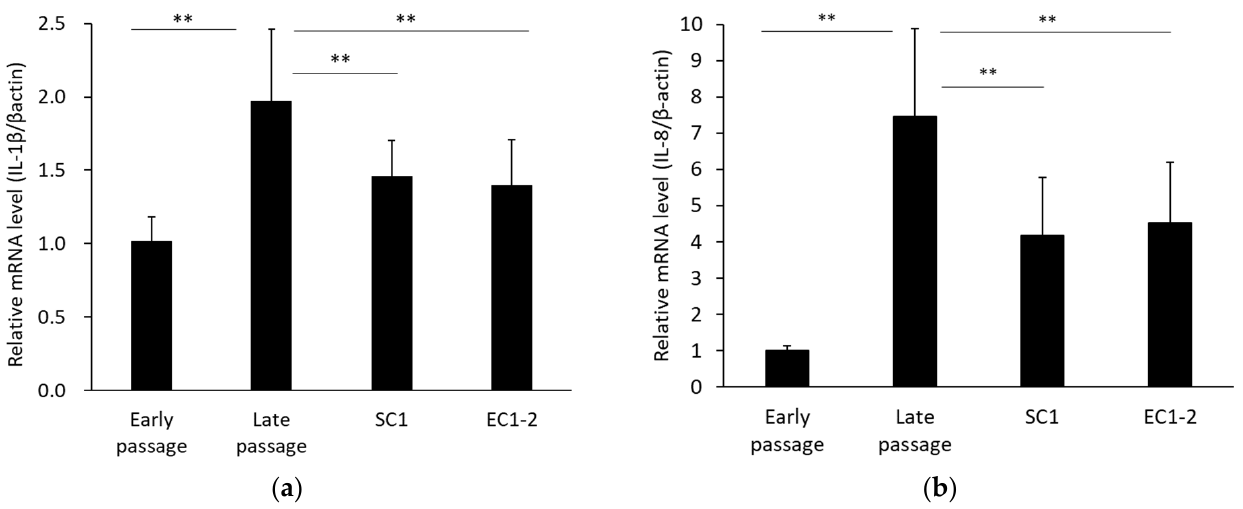
Figure 4. Effects of SC1 and EC1-2 on SASP. The relative mRNA levels of IL-1 β ( a ) and IL-8 ( b ) normalized with β -actin were evaluated with qRT-PCR. Data were reported as means ± SD of three independent experiments. ** p < 0.01 vs. Late passage group by Dunnett’s